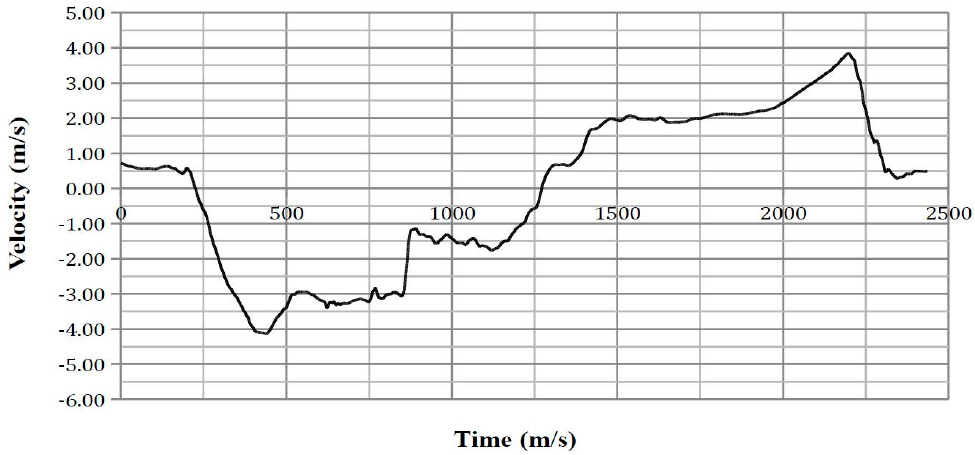
Figure A21. ATD Position 8 lower spine y-axis velocity.